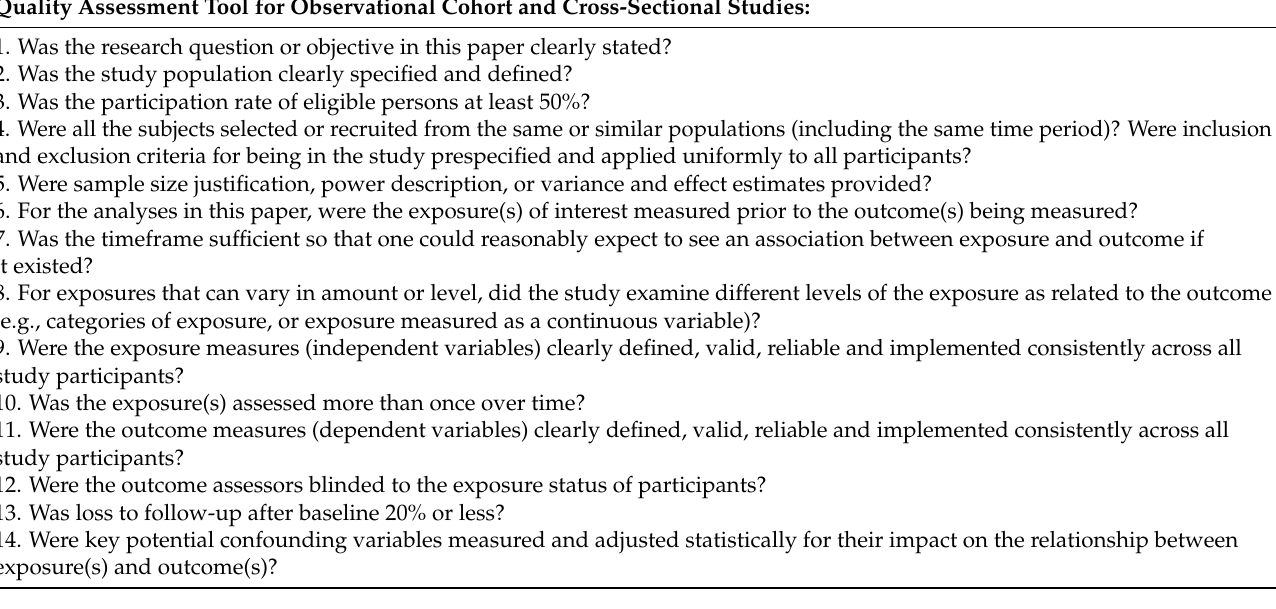
Table 2. Questions used for the quality